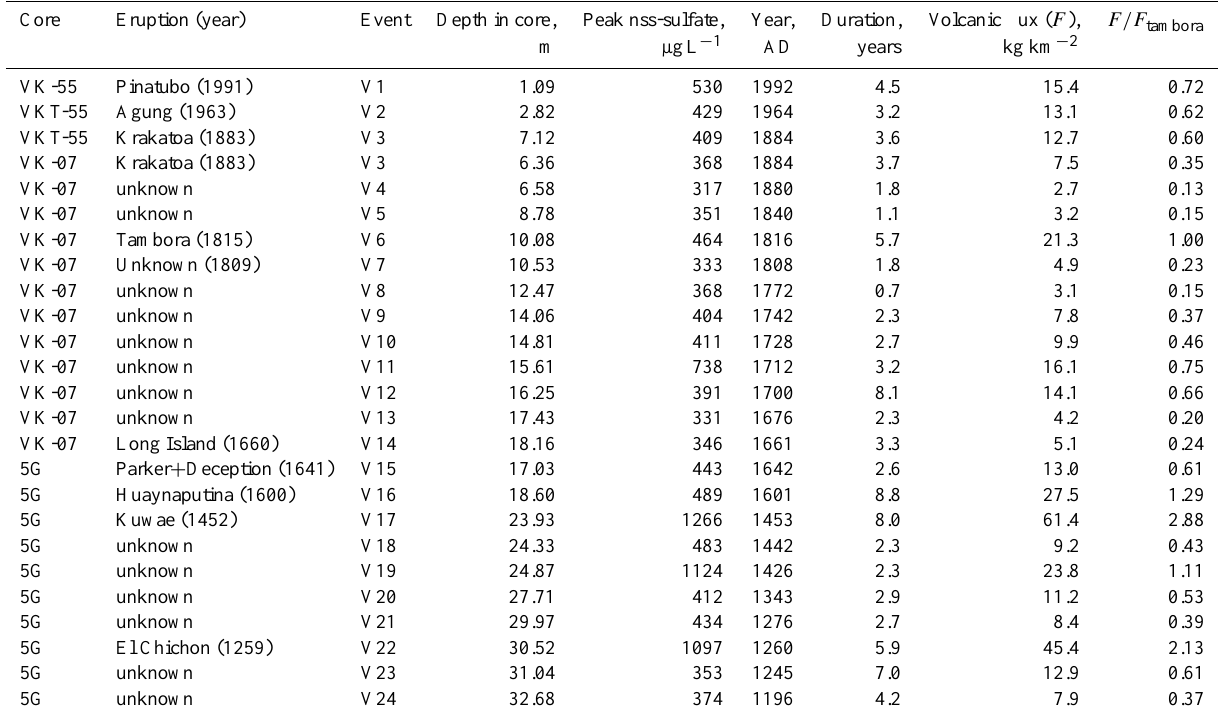
Table 3. Volcanic events for the last 900years in the Vostok area